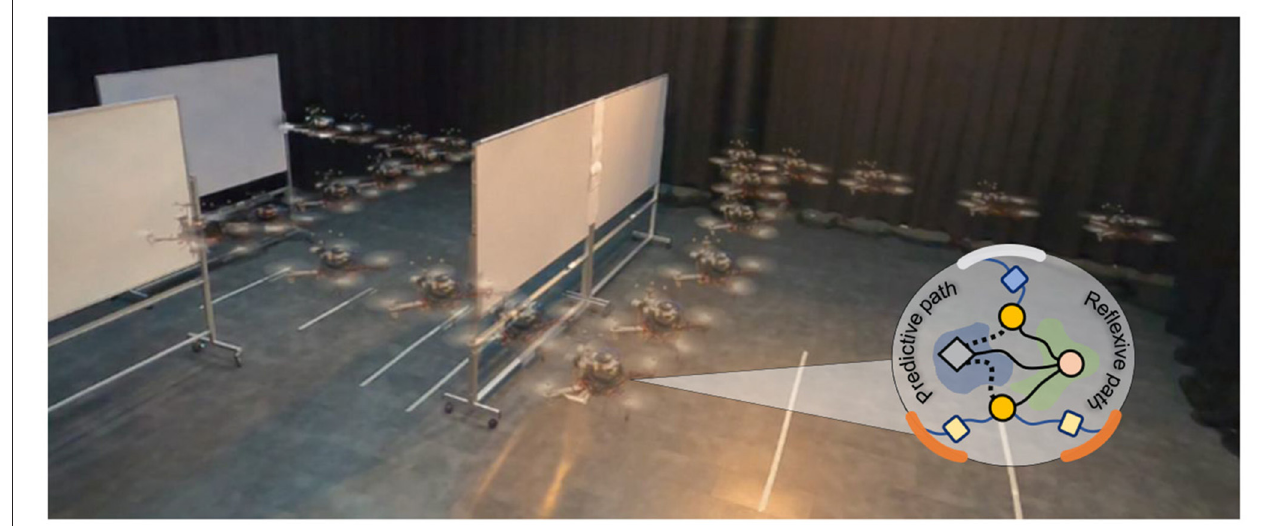
FIGURE 1 | Speed adaptation algorithm, based on neural control with online correlation-based learning capability (or considered as neural proactive control, insert circle). A reflexive path is the path for generating reactive behavior, while a predictive path is the path for performing online learning and generating adaptive behavior. The algorithm serves as a primitive control function for obstacle avoidance. It allows the UAV to automatically fly (see from right to left) and proactively adapt its flying speed and brake at a safe distance to avoid an